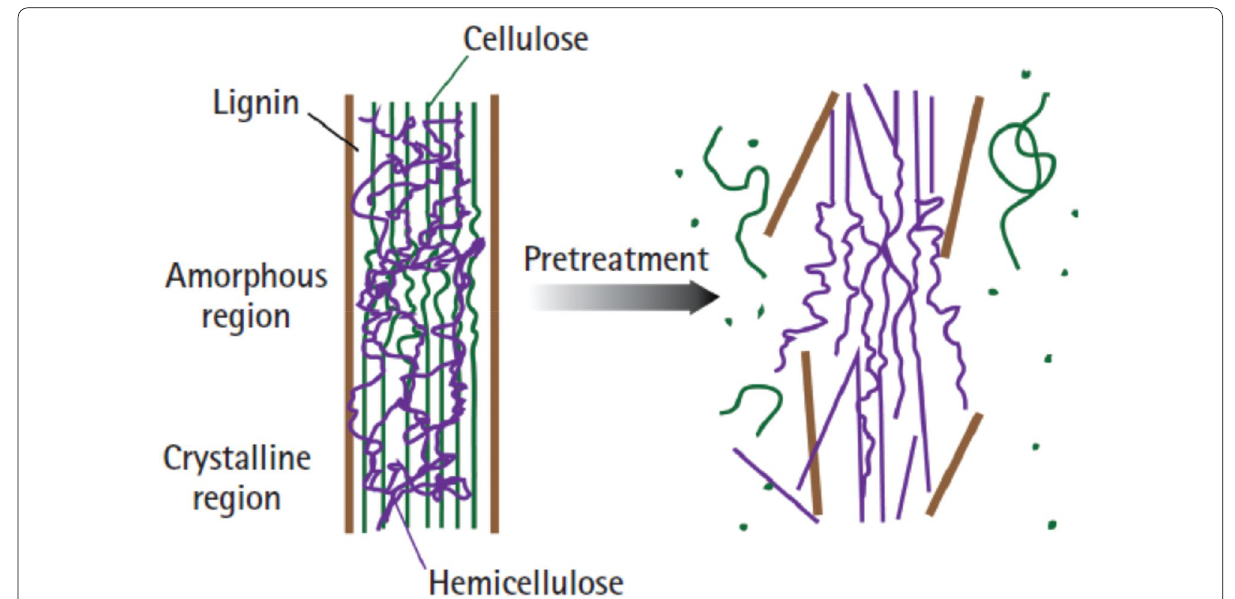
Fig. 1 Effect of pre-treatment on the chemical structure of lignocellulosic biomass (Tumuluru et al., 2011)